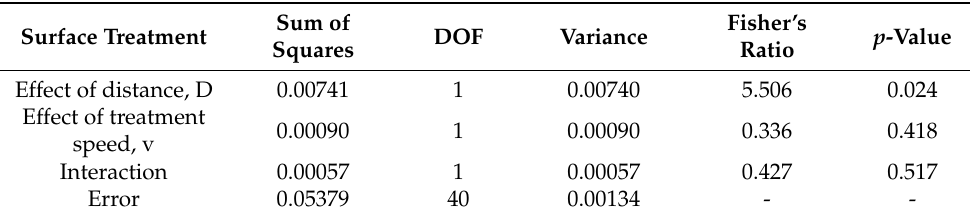
Table 6. Results of ANOVA applied to a 2-by-2 experiment (A1/B1 = D5_v100, A1/B2 = D10_v100, A2/B1 = D5_v200, A2/B2 =